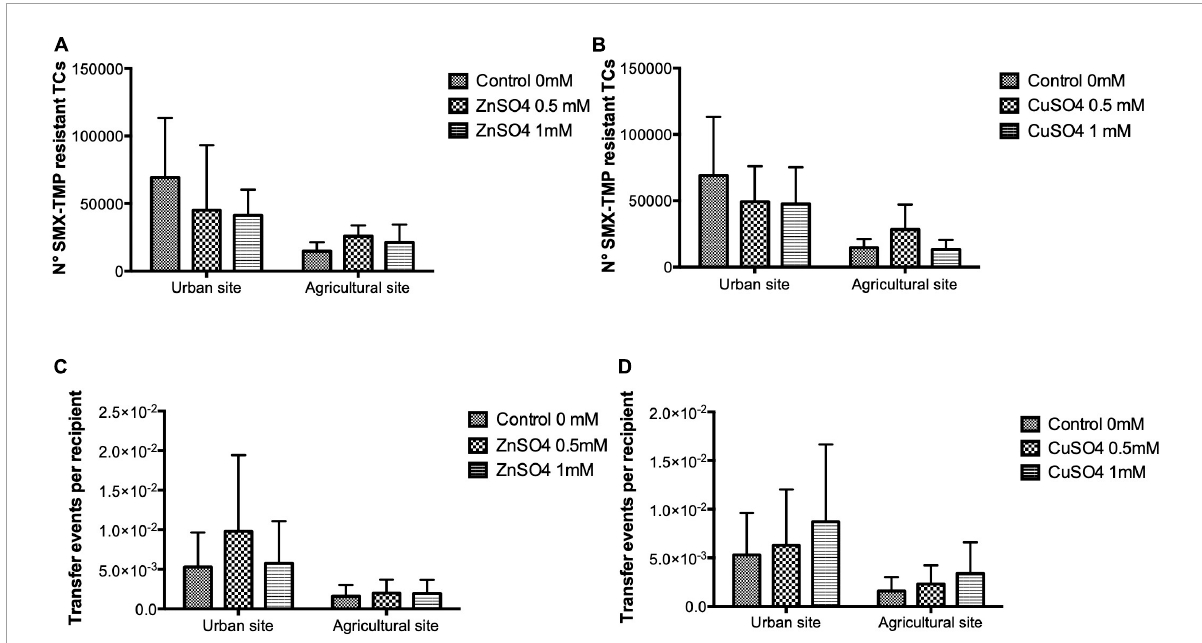
FIGURE2 The number of transconjugants and transfer frequencies (TFs) obtained from conjugation experiments in LB media supplemented with ZnSO 4 and CuSO 4 at 0.5 and 1 mM. Conjugation experiments used waterborne bacterial donor communities from two La Paz River basin sites and E. coli CV601 as the recipient strain. The bars represent mean values of the number of SMX-TMP resistant transconjugants (A,B) and transfer events per recipient (C,D) in the presence of ZnSO 4 and CuSO 4 . Data were obtained from three independent conjugation experiments. The error bars represent the standard deviation of the mean. For both sampling sites, the number of SMX-TMP-resistant transconjugants and TFs did not differ significantly between the experiments performed in LB media and LB media supplemented with